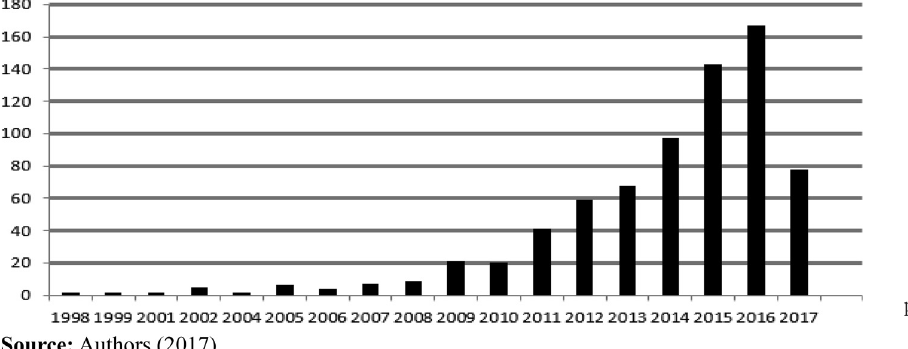
Figure 1. Evolution of the annual number of papers on fi nancial